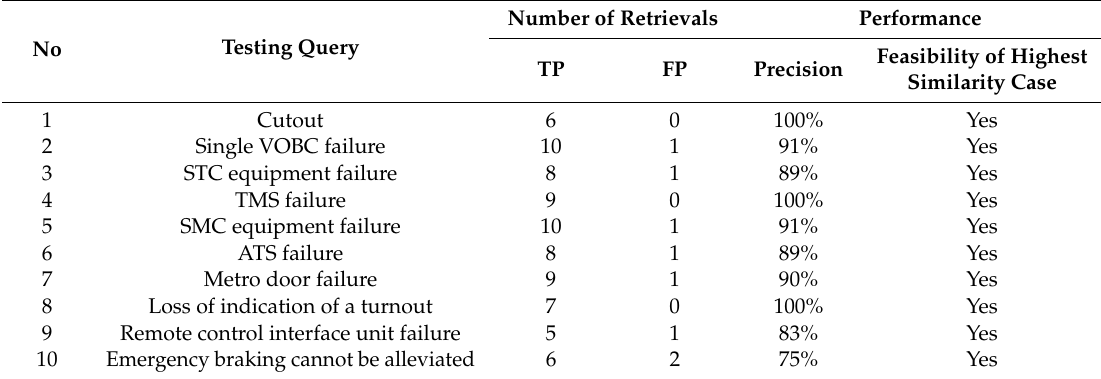
Table 5. Expert review